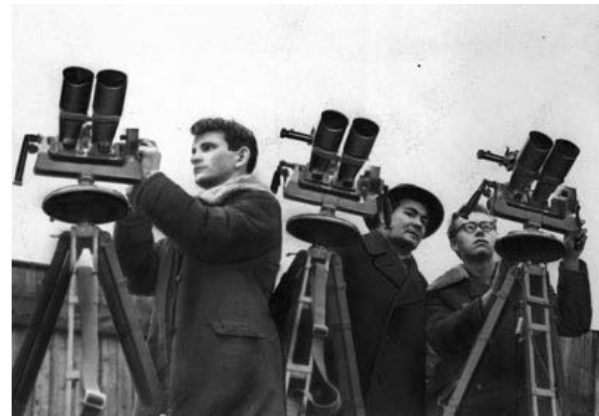
Figure 2. The northernmost Arkhangelsk station, Russia Array of TZK (Zenithal Tube or Truba Zenitnogo Komandira) binoculars readied for observation.